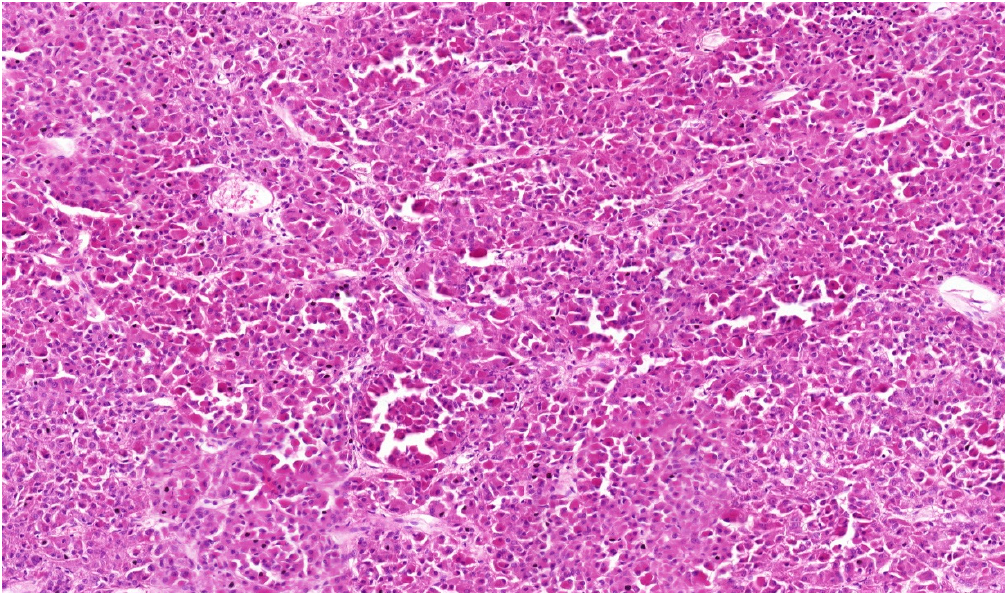
Figure 4. RCC with TFEB break and TFEB amplification. 4× magnification.